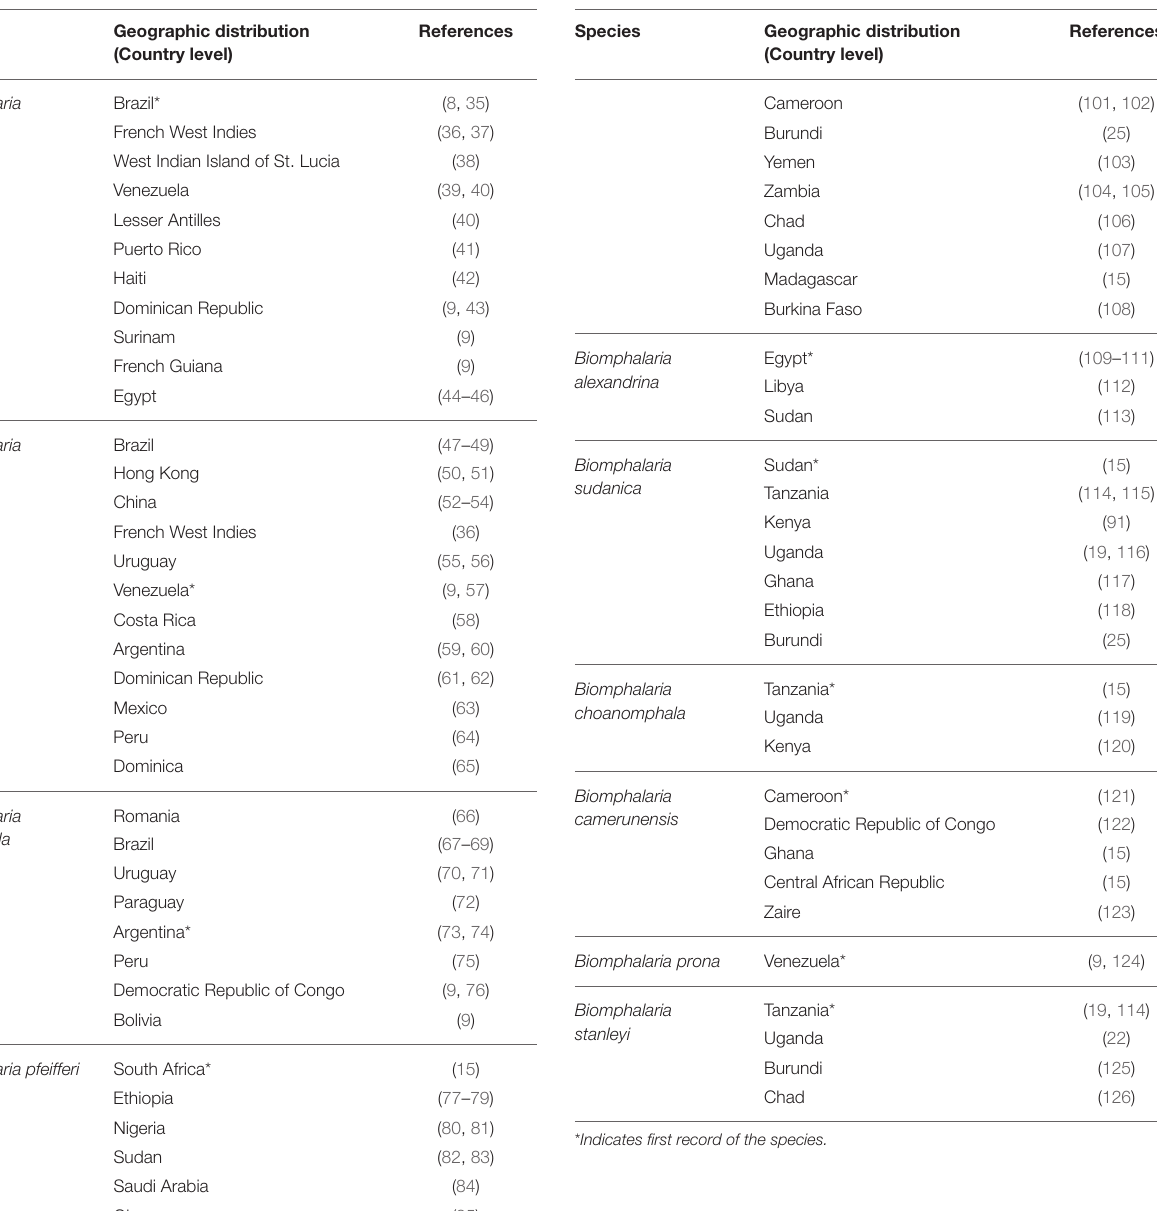
spread of schistosomiasis (140–142). In Egypt, high temperatures appear to reduce snail breeding and March is the month of maximal breeding for B. alexandrina (143). Yousif et al. (144) found that B. alexandrina populations exhibited two peaks of populations density that differ in heights depending on the extent of water temperature and winter closing. The first peak is from April-May and the second is from November-December. These two peaks are permeated by two lows following the Winter Closure and during the hot summer season. Under laboratory condition, B. alexandrina has optimal growth and egg laying at 26–28 ◦ C (145). A similar temperature range was also found with B. glabrata (146). Also, a positive correlation